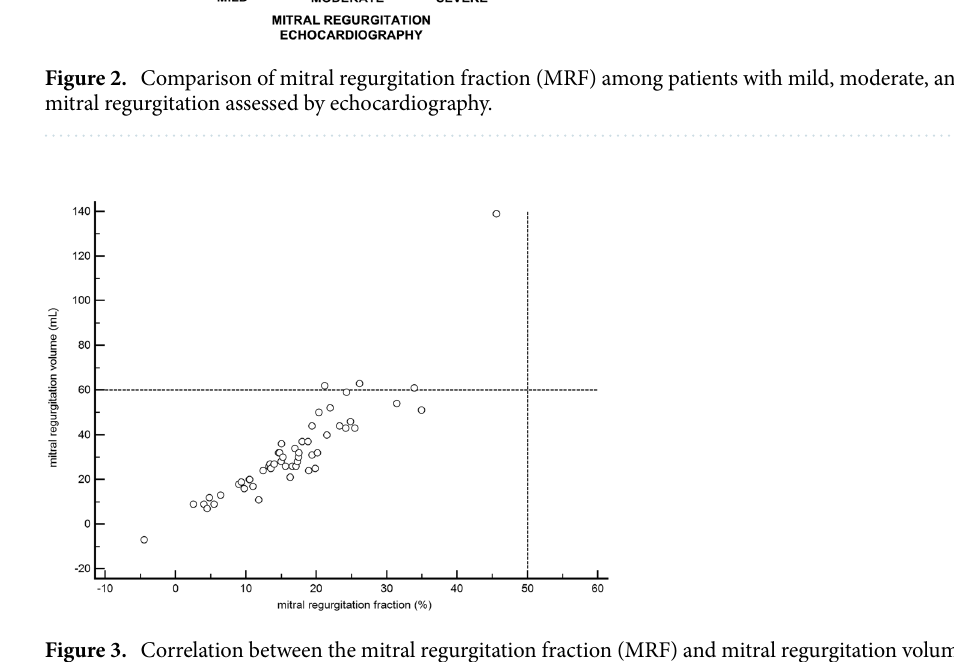
Figure 3. Correlation between the mitral regurgitation fraction (MRF) and mitral regurgitation volume